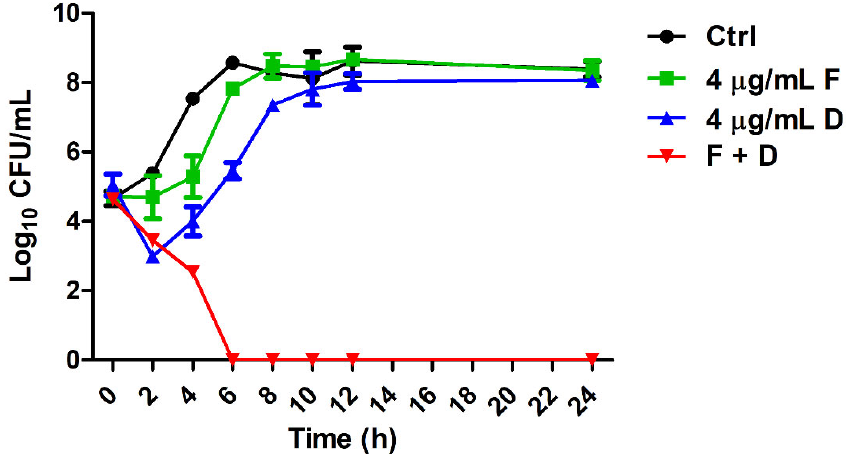
Figure 2. Synergistic action of fingolimod and doripenem against CREC. E. coli KBN12P05816 was treated with fingolimod and doripenem, plated with a spreader on Muller–Hinton agar (MHA), and incubated at 37 °C for 24 h. The CFU/mL values were recorded. ( ● ) Untreated controls, ( ■ ) 4 μ g/mL of fingolimod, ( ▲ ) 4 μ g/mL of doripenem, and ( ▼ ) the combination of 4 μ g/mL of fingolimod and 4 μ g/mL of